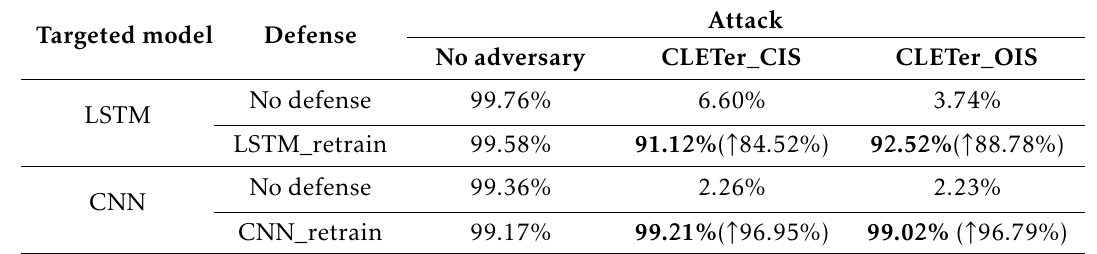
Table 5. The results of recalls for two retrained